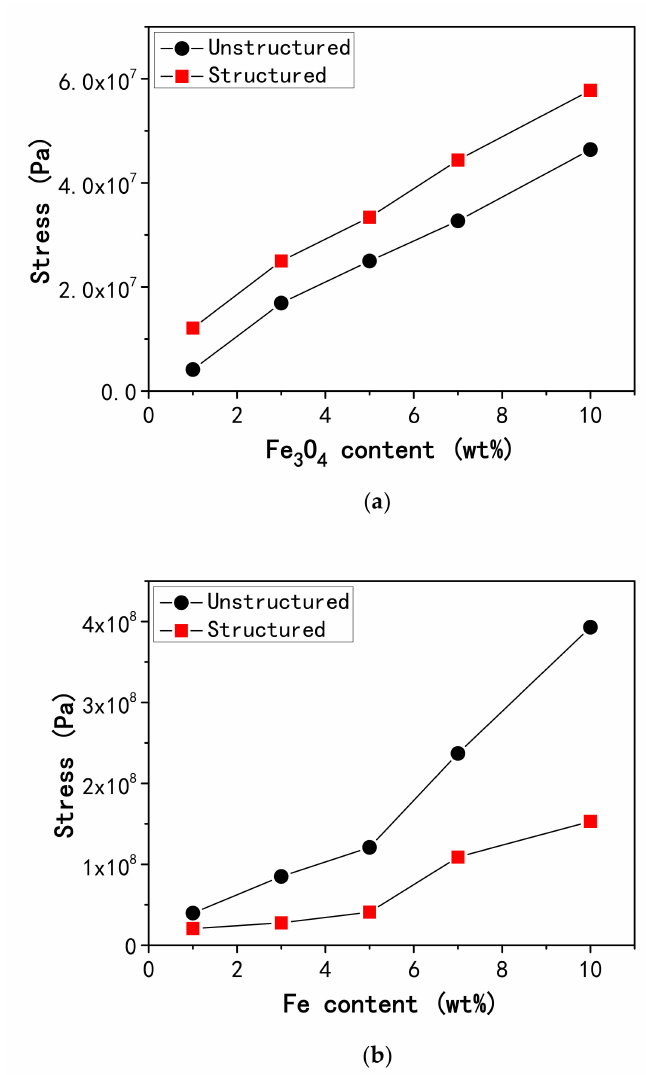
Figure 6. The film magnetostrictive stresses for the unstructured and structured samples with varied weight fractions of magnetic nanoparticles: ( a ) Fe 3 O 4 -PDMS films, and ( b ) Fe-PDMS